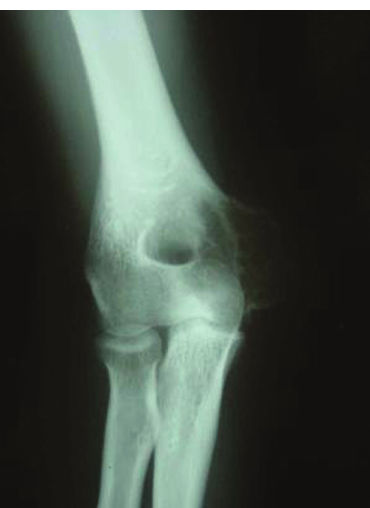
Figure 1: AP view of the elbow with radiolucent lesion of the medial condyle.